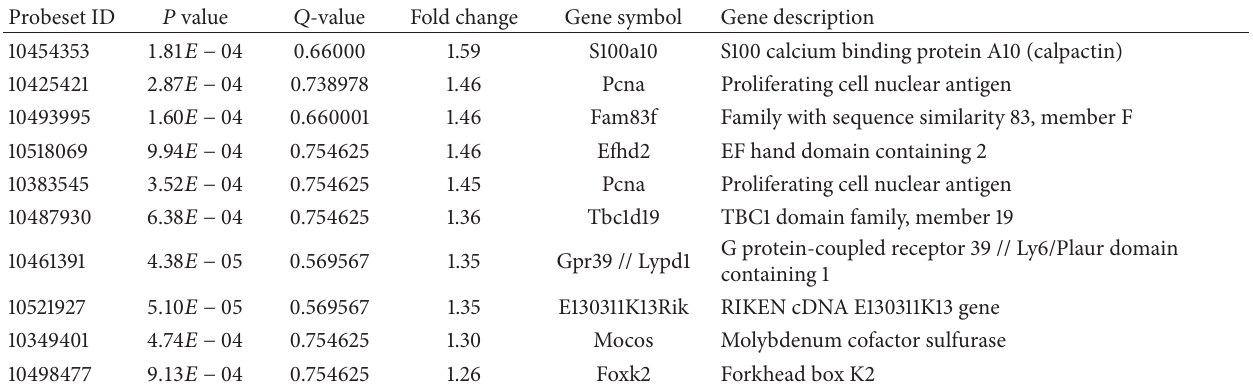
Table 2: List of genes whose expression in mouse liver is regulated by chronic VPA treatment as measured by Affymetrix GeneChip Mouse Gene 1.0 ST